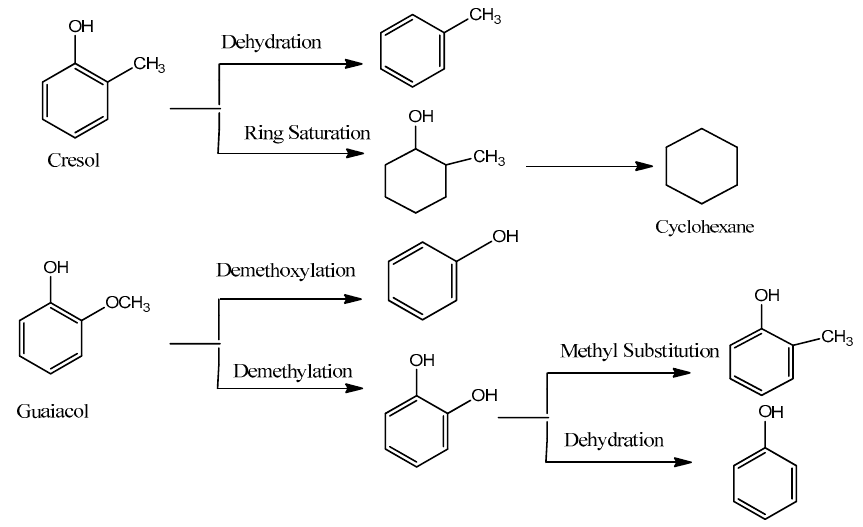
Figure 6. The possible mechanism routes for phenol monomers.